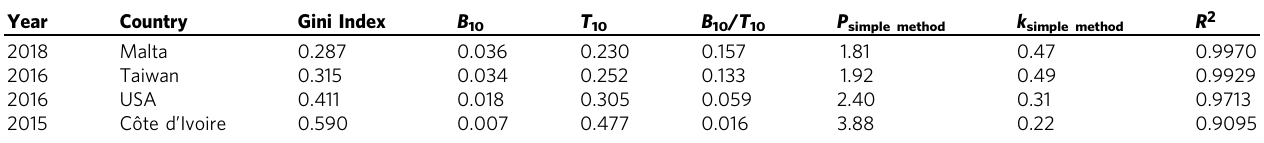
Table 1 The estimated parameters P and k for the Lorenz curves of four countries calculated using the simple method that utilizes the data on the Gini index and the income shares of the bottom 10% and the top 10% as published in the